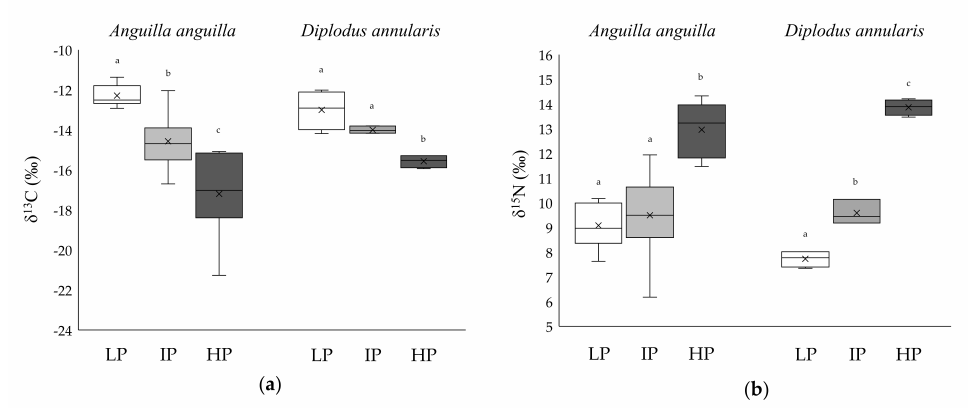
Figure 4. Boxplot of the distribution of δ 13 C ( a ) and δ 15 N ( b ) isotopic signature of Anguilla anguilla and Diplodus annularis in each lake: LP, IP and HP: low, intermediate and high eutrophication. For each lake, the thick horizontal line represents the median of the distribution, the box includes 50% of the data, the symbol (x) represents the mean and the whiskers reach the highest and lowest value within 95% of the distribution. Di ff erent letter (a, b, c) within panels indicates di ff erences among lakes (Mann–Whitney test with Bonferroni correction in cases of multiple comparisons; p < 0.05). Overall, no correlation between the body length and δ 13 C (% (cid:24) ) of Anguilla anguilla was observed in any lake (Pearson correlation, p >